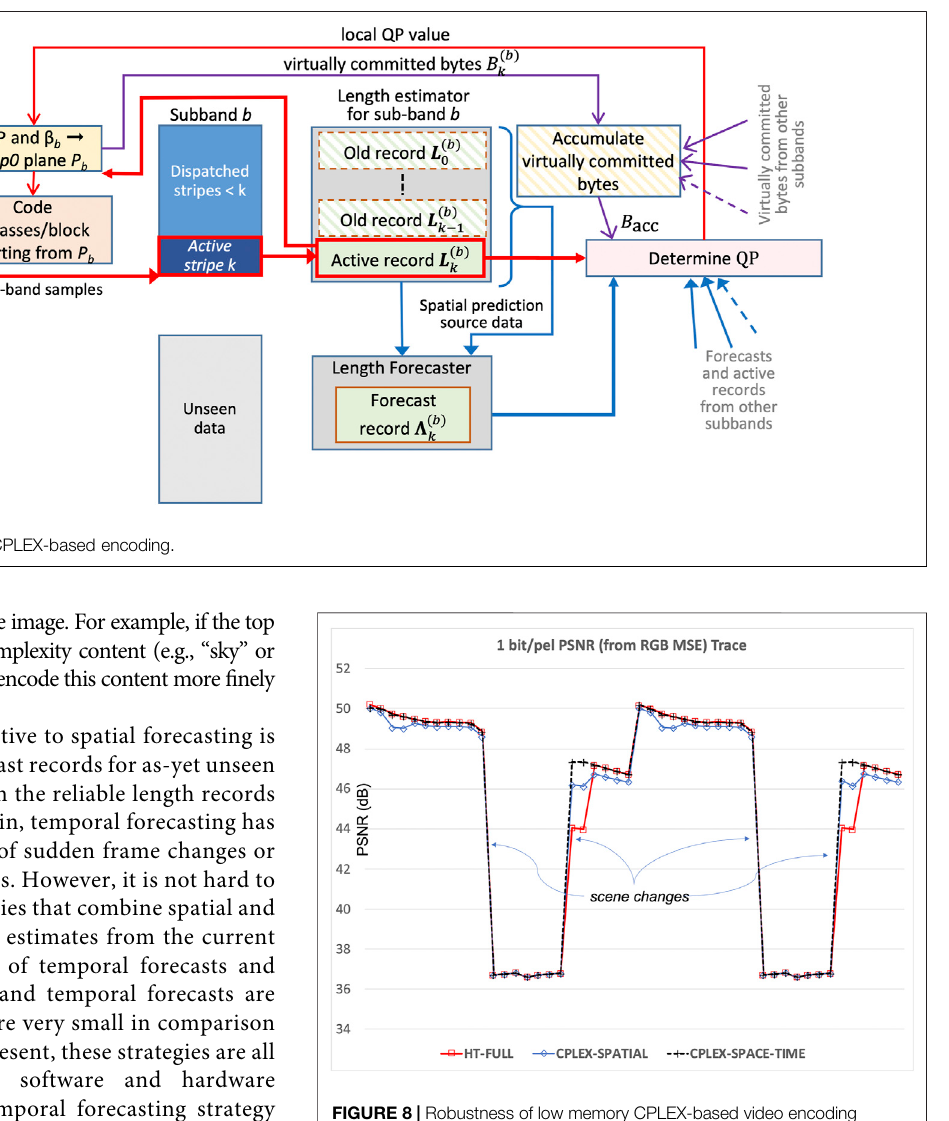
FIGURE 8 | Robustness of low memory CPLEX-based video encoding with spatio-temporal forecasting, illustrated using a temporal trace of the frame-by-frame decompressed PSNR resulting from three different complexity constrained encoding